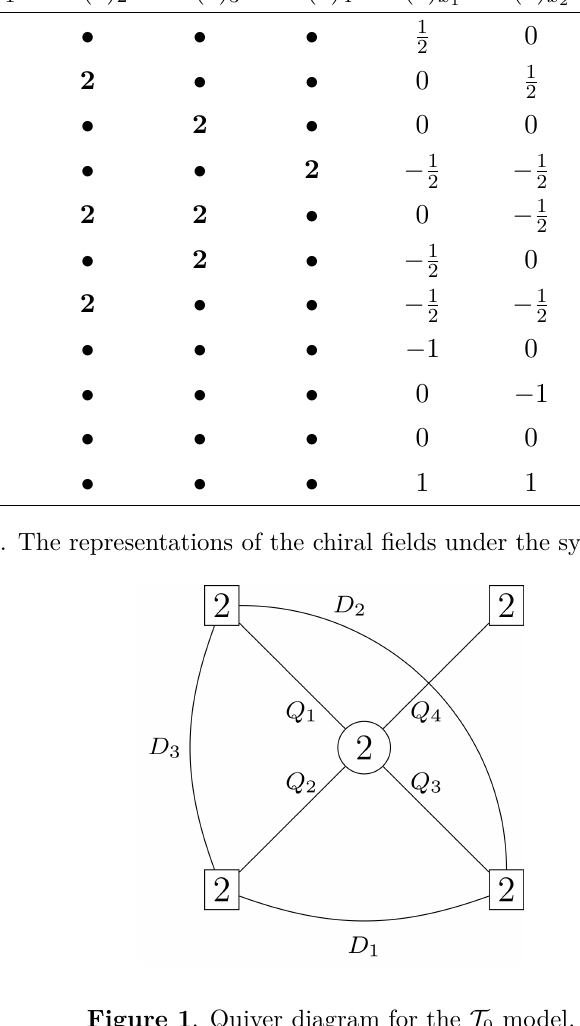
Figure 1 . Quiver diagram for the T 0